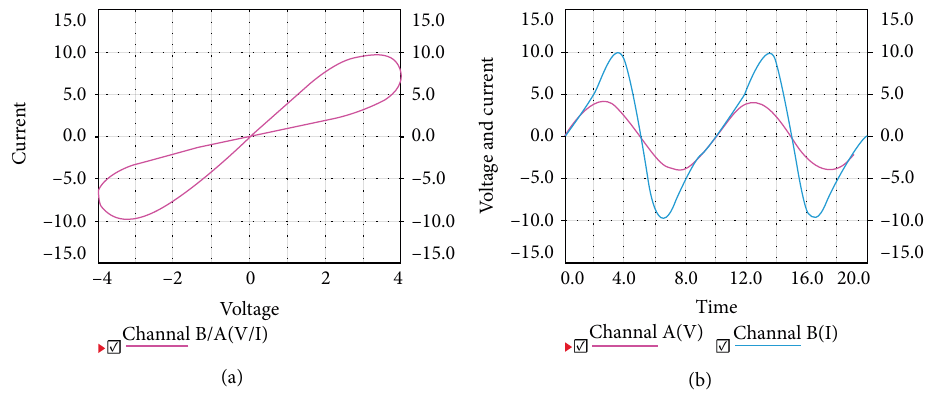
Figure 4: Simulation result of Multisim, (a) pinched hysteresis loop, and (b) timing